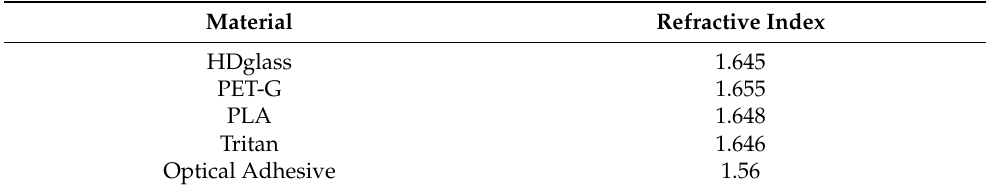
Table 3. Measured refractive index values at around 585